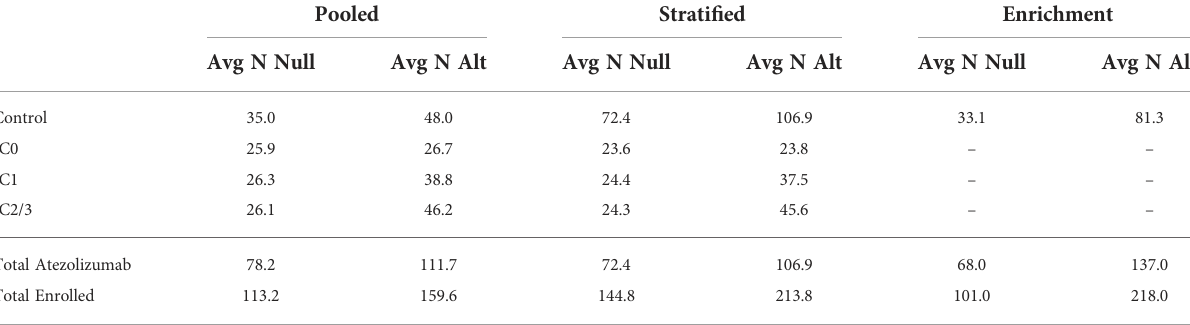
TABLE 2 Average sample size under the null ( “ Avg N Null ” ) and average sample size under the alternative ( “ Avg N Alt ” ) by design and treatment subgroup.